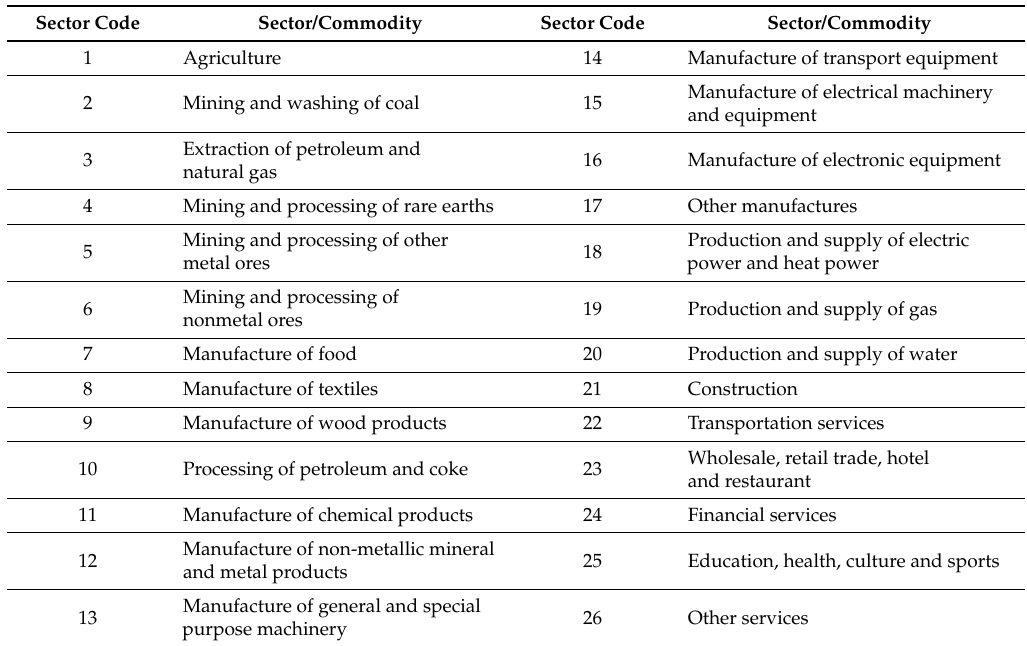
Table 1. Sectors and commodities in the China’s DCGE